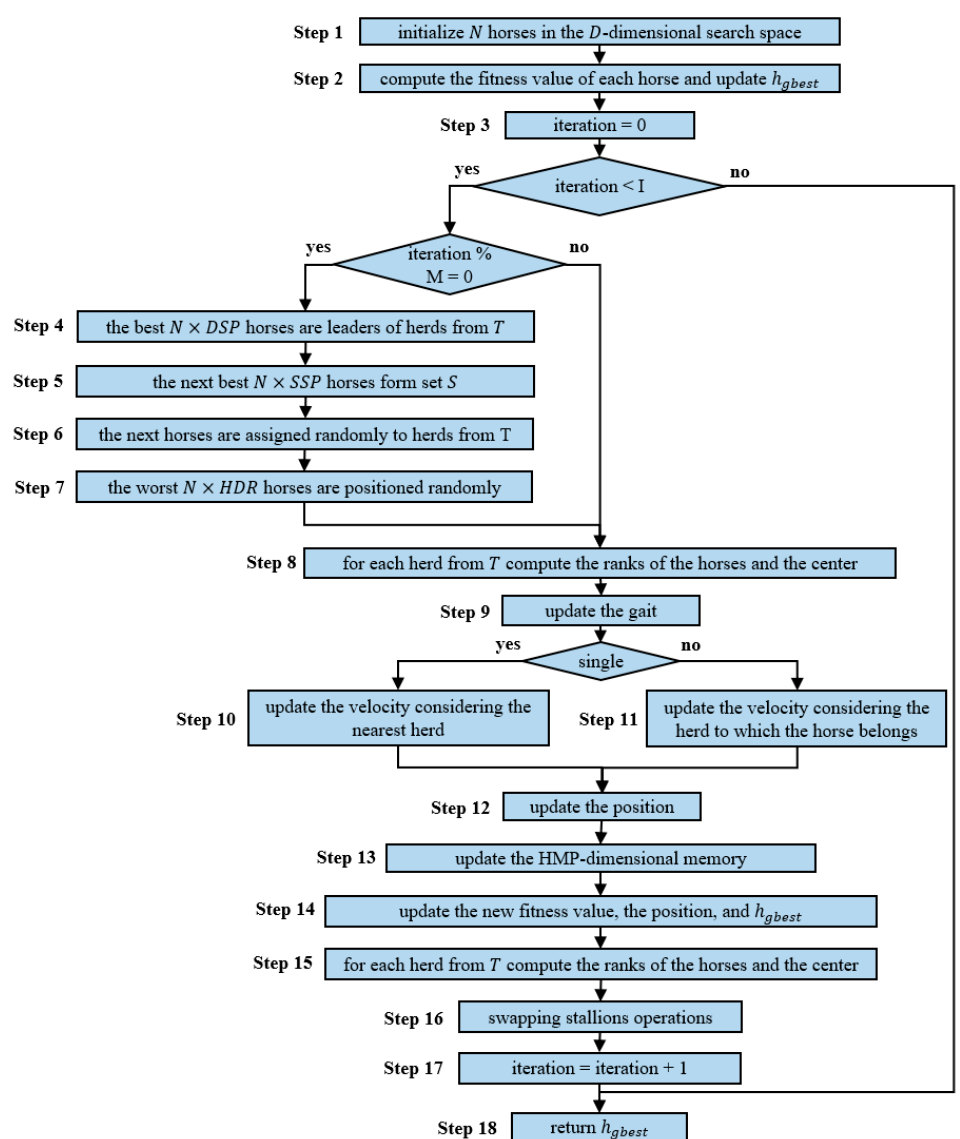
Figure 1. HOA high-level view.